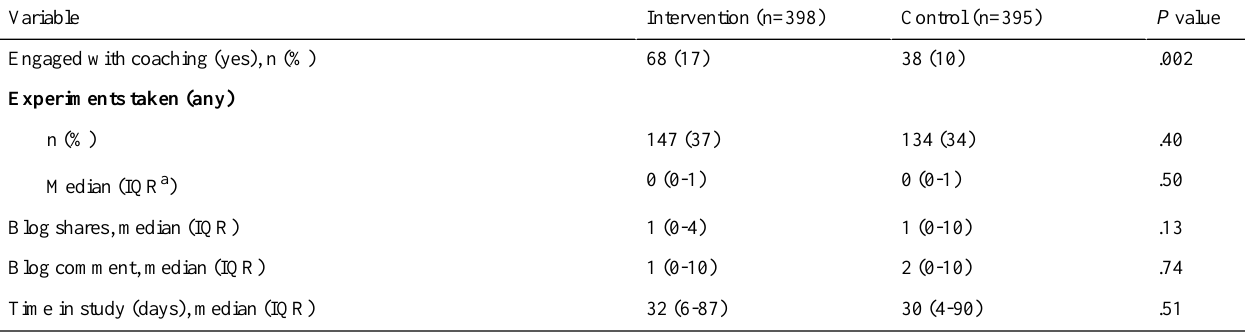
Table 2. Program use by study group (N=793).